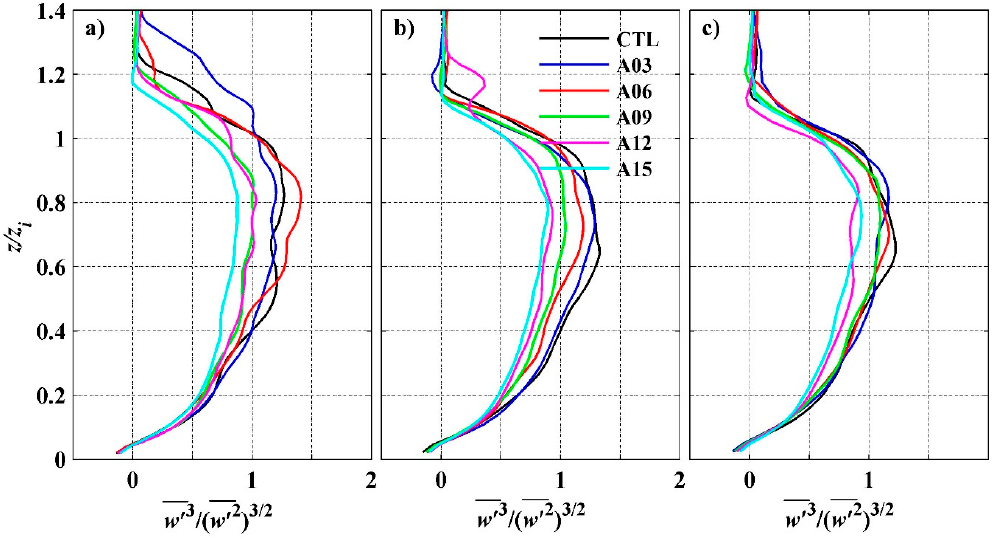
Figure 12. Profiles of vertical velocity skewness ( w (cid:48) 3 / ( w (cid:48) 2 ) ) for the cases with three different stratification strengths in the free atmosphere: ( a ) 3 K km − 1 , ( b ) 6 K km − 1 , and ( c ) 9 K km − 1 . The color scheme for cases with different AOD is the same as in Figure 8.